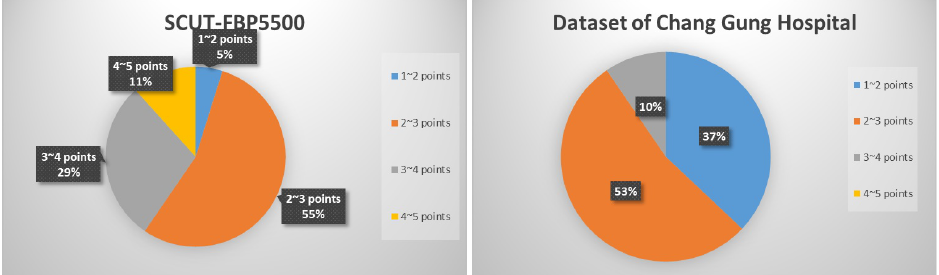
Figure 2. Percentage of data score